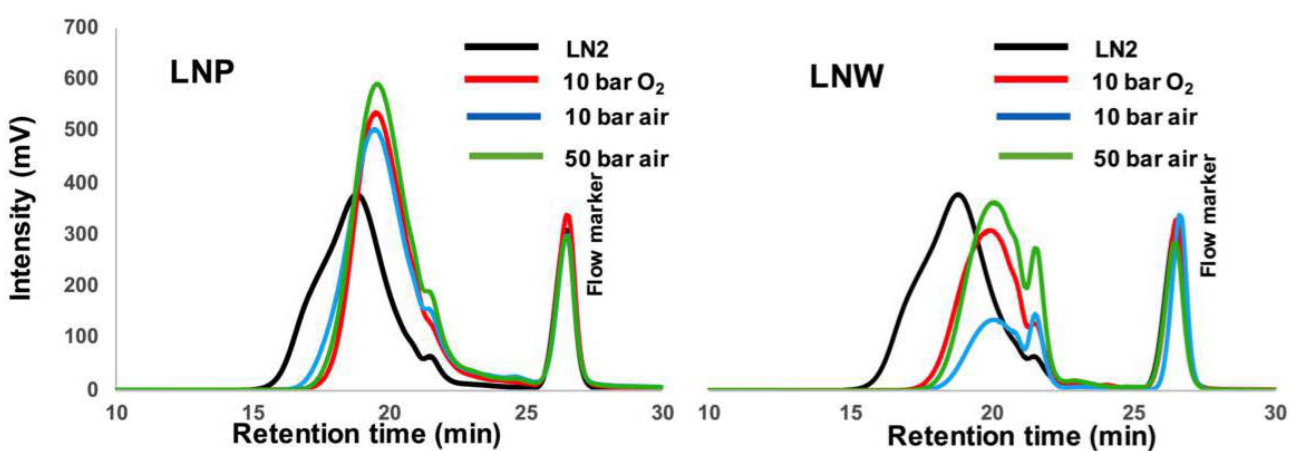
Figure 5. SEC chromatograms of LNP and LNW after oxidative depolymerization of LN2 (black) with different air or oxygen pressure, at 120 °C.